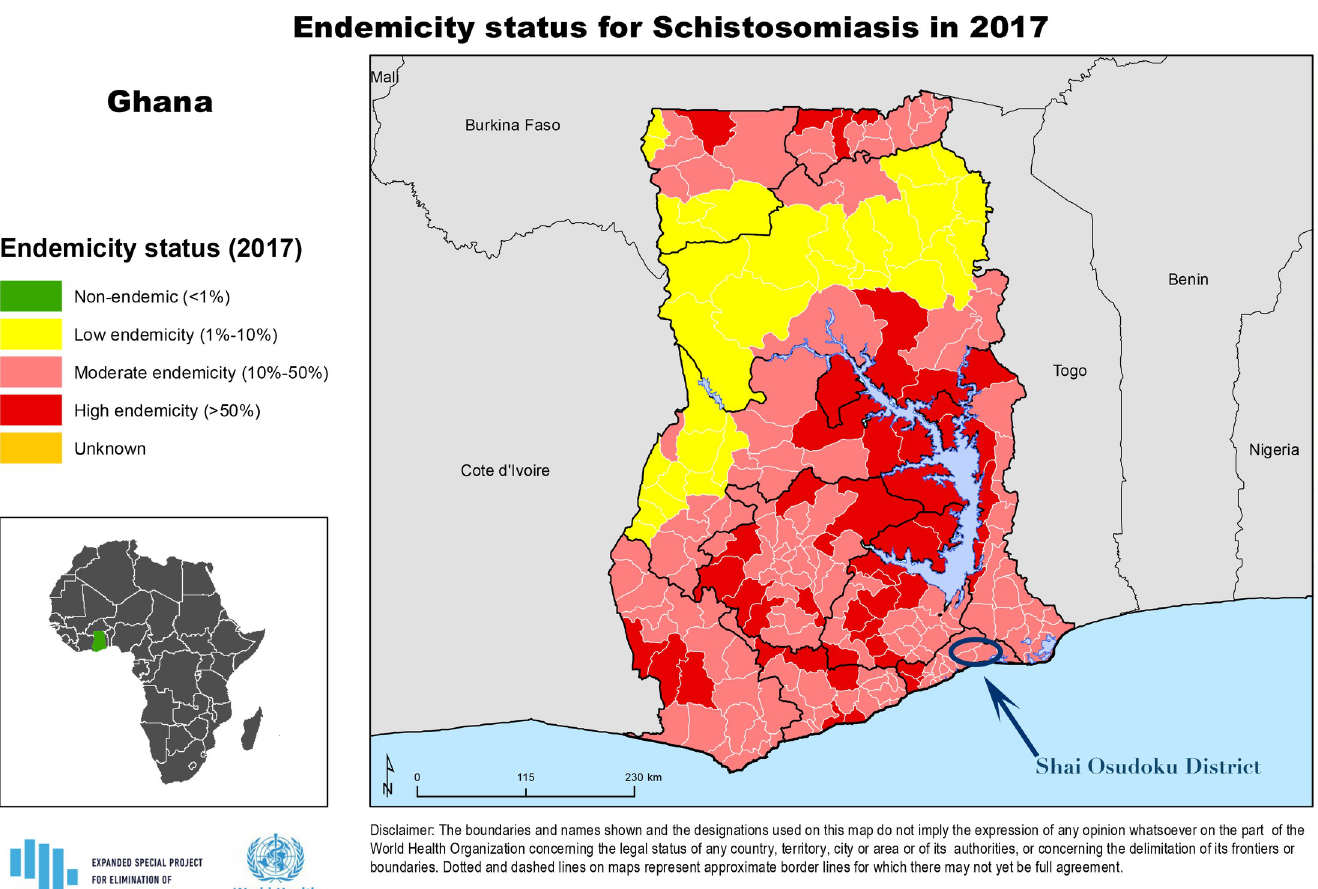
Fig 1. Endemicity status for schistosomiasis in Ghana